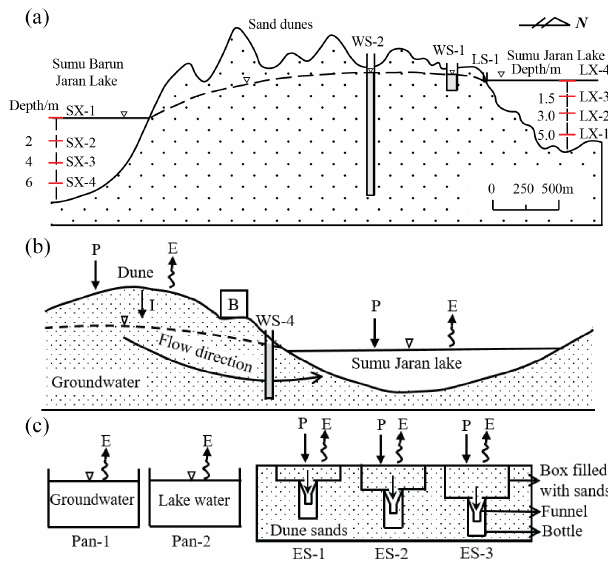
Figure 2. Schematic diagram showing the cross-section profile be- tween the Sumu Jaran Lake and the Sumu Barun Jaran Lake as well as the water sampling points (a) , the groundwater flow direction (b) and the evaporation experiments (c) in the Sumu Jaran Lake area. P denotes the precipitation, E is the evaporation and I is the infil- tration. Pan-1 and Pan-2 are initially filled with groundwater from WS-4 and lake water from the Sumu Jaran Lake,